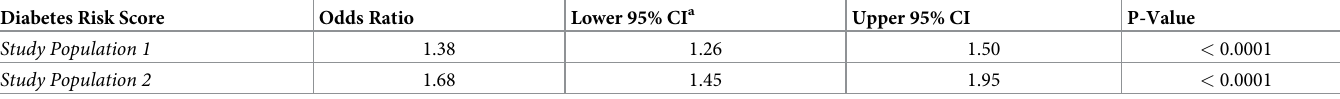
Study population 1. In study population 1, we observed a significant relationship between the diabetes risk score and the development of diabetes upon rescreening. On average, the odds ratio of developing diabetes in the future was 1.38 (95% CI: 1.26–1.50, p < 0.0001) for every unit increase in the diabetes risk score. We evaluated the final model’s ability to correctly identify one as having future diabetes based on their risk score using bootstrap resamples (1000x) from the full dataset, which yielded an average area under the receiver operating Table 4. Logistic regression results for continuous diabetes risk scores estimating future incidence of diabetes for study population 1 (US former DOE workers, 2005–2015) and study population 2 (Colorado workers from multiple businesses, 2010–2014). Diabetes Risk